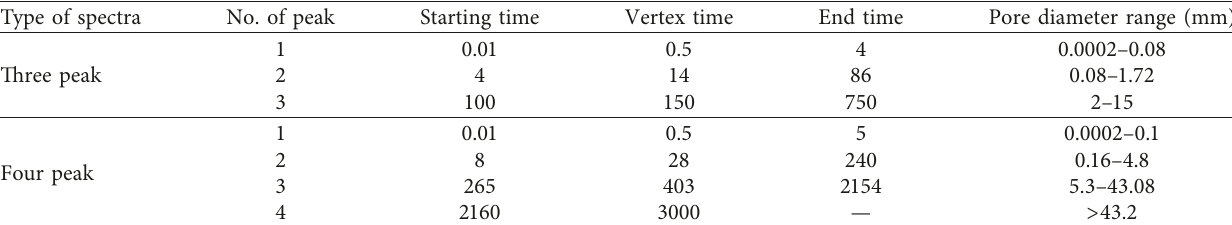
Figure 3: T 2 spectra of sandstone. (a) Three-peak spectra. (b) Four-peak spectra. Table 1: Sandstone pore parameters.